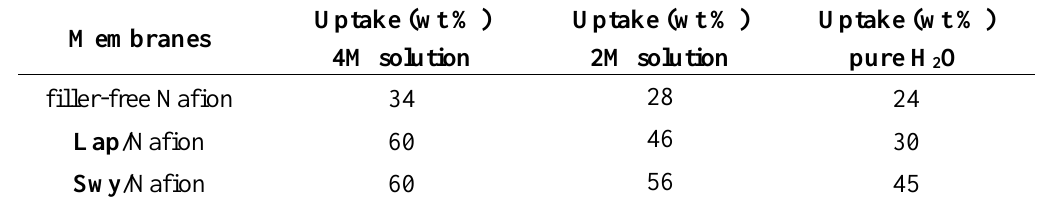
Table 1. Methanol solution and water uptake (wt %) of the membranes at room temperature.